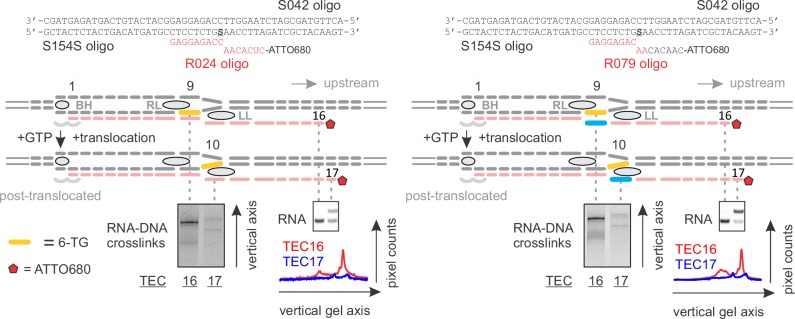
RNA:DNA photocrosslinking with 6-TG reflects the physical accessibility of RNA to DNA.TECs containing 6-TG in the template DNA nine nucleotides upstream of the RNA 3’ end were walked by up to two nucleotides and illuminated with the UV light. The RNA:DNA complementarity was initially nine (Left) and eight (Right) base pairs. 6-TG does not pair with RNA in the TEC16 on the right: the mismatch against 6‑TG is colored light blue. The vertically stacked panels were spliced from the same gel and the pixel counts were linearly scaled to span the full 8 bit grayscale range within each panel.